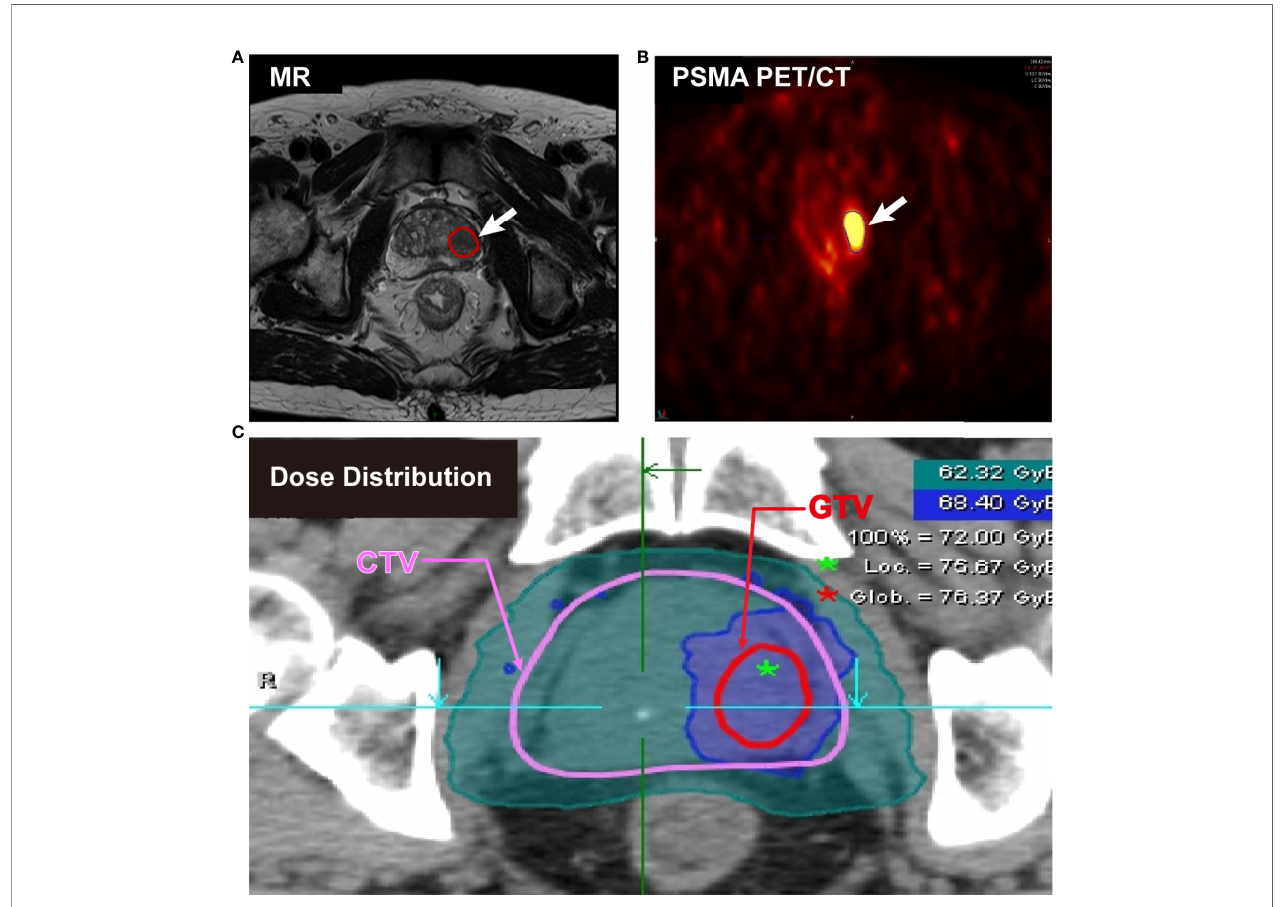
FIGURE 2 | Imaging examination and delineation of tumor volume from a cT3aN0M0 patient. (A) Positive PCa lesions on MR image. (B) High uptake positive lesions on 68 Ga-PSMA PET/CT image. (C) Clinical target volume (CTV) (red) and gross target volume (GTV) (pink) for simultaneous integrated boost (SIB) on planning